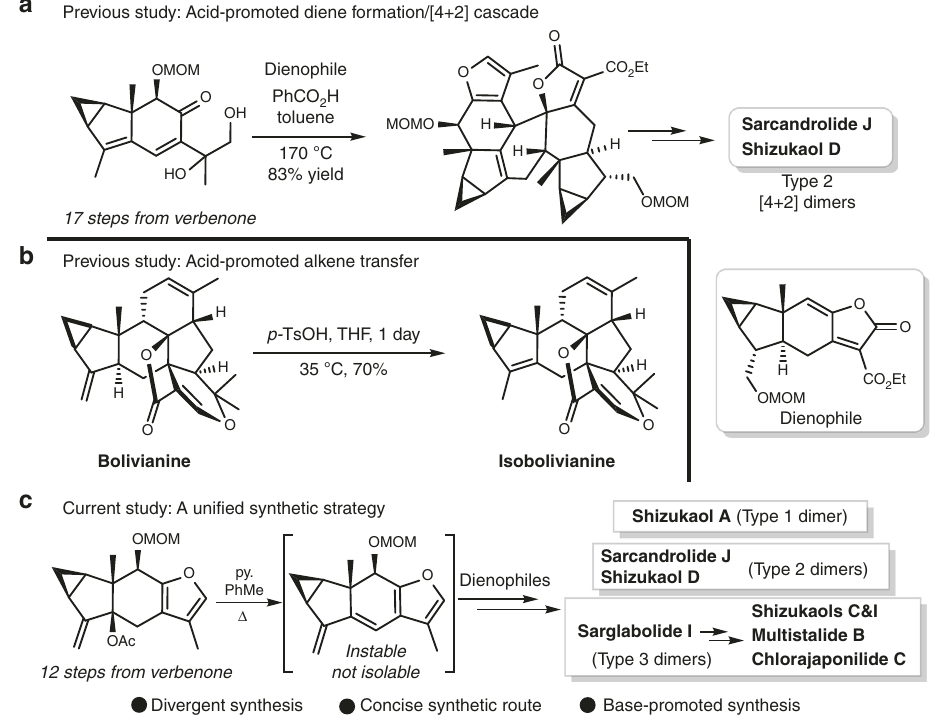
Fig. 2 Evolution from an acid-promoted cascade to the current uni fi ed strategy. a The skeleton of type 2 dimeric lindenane sesquiterpenoids was constructed through an acid-promoted diene-formation/[4 + 2] cascade. b Bolivianine was transformed to isobolivianine via the acid-promoted exo / endo cyclic alkene isomerization. c A uni fi ed synthetic strategy is developed for the synthesis of three types of dimeric lindenane